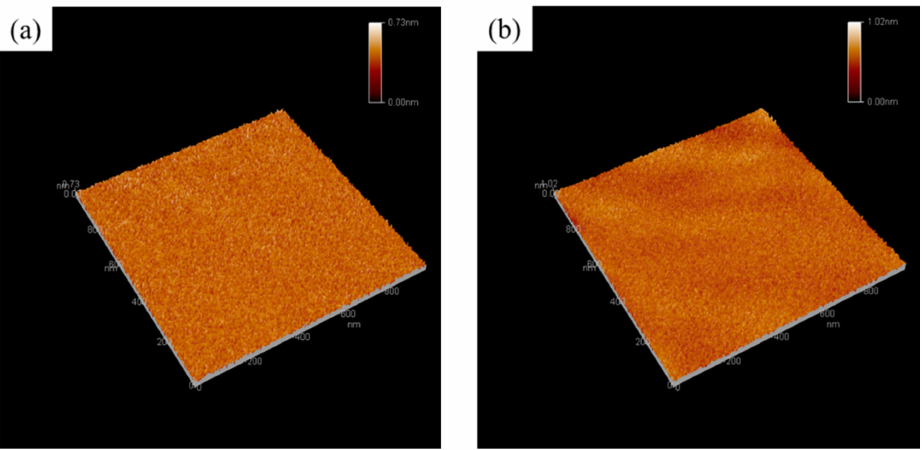
Figure 8. The atomic force microscopy (AFM) image of the as-prepared nanohybrid silica polyacrylate coating films. ( a ) Without adding DFMA and ( b ) DFMA/MMA weight ratio of